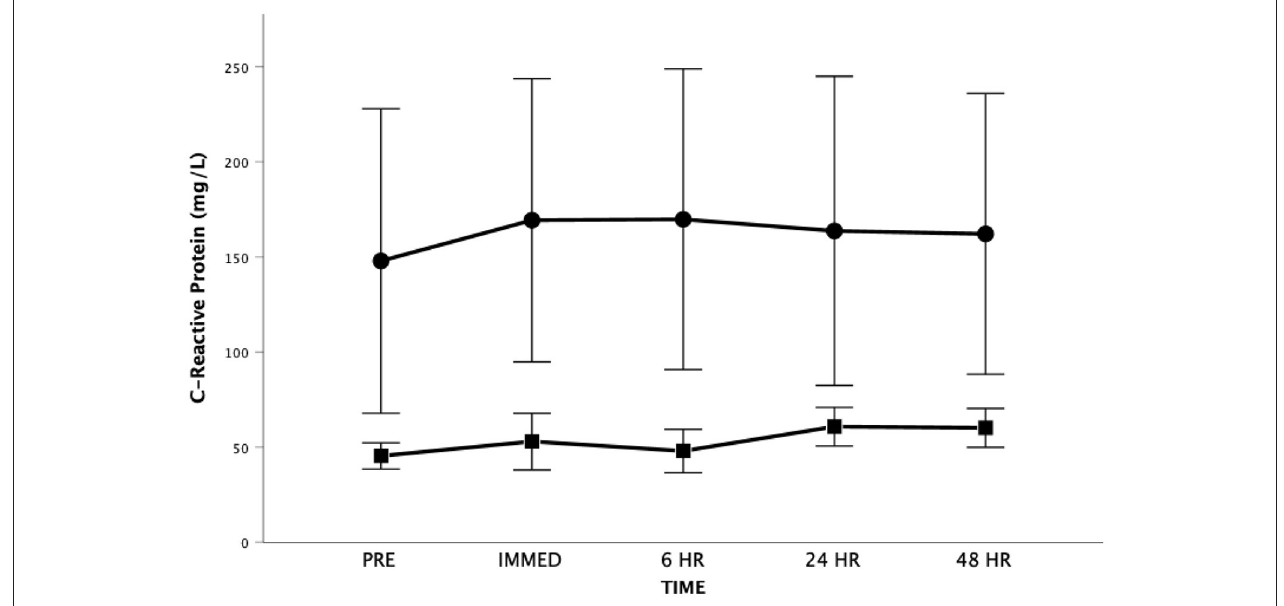
FIGURE 6 | High sensitivity C-Reactive Protein as a function of time. Means ± SD. Circle = Steady State; Square = Interval. Error Bars = ± SEM.